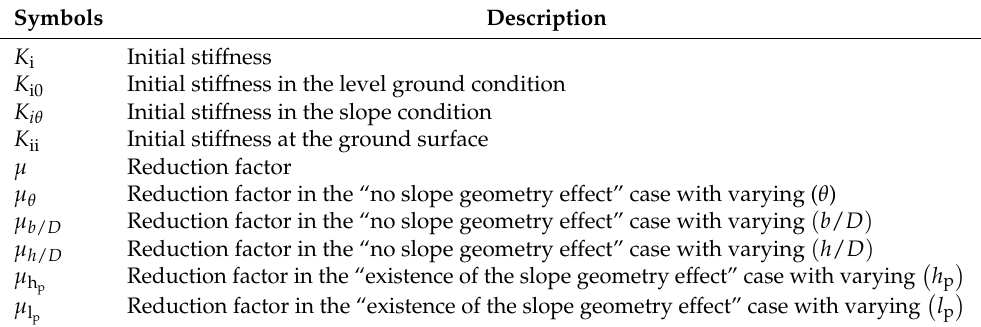
Table 2. The description of some used symbols. Symbols